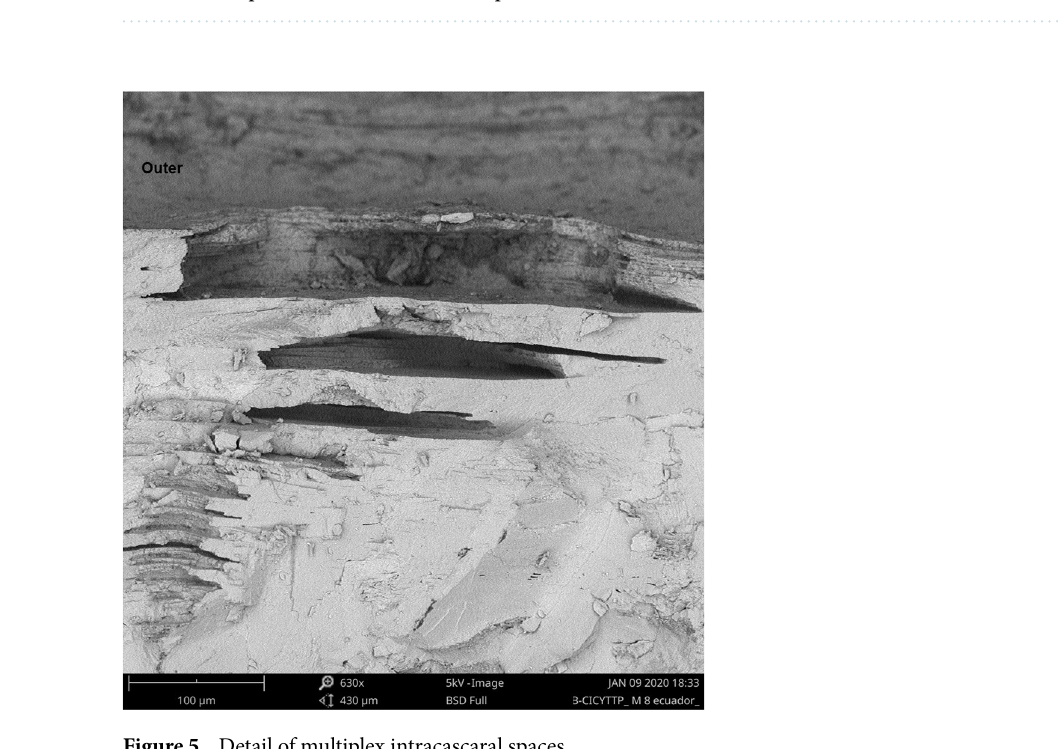
Figure 4. Radial view of an eggshell under SEM (Scanning Electron Microscope) showing a multiplex intracascaral spaces above the cone of the pore-canal.